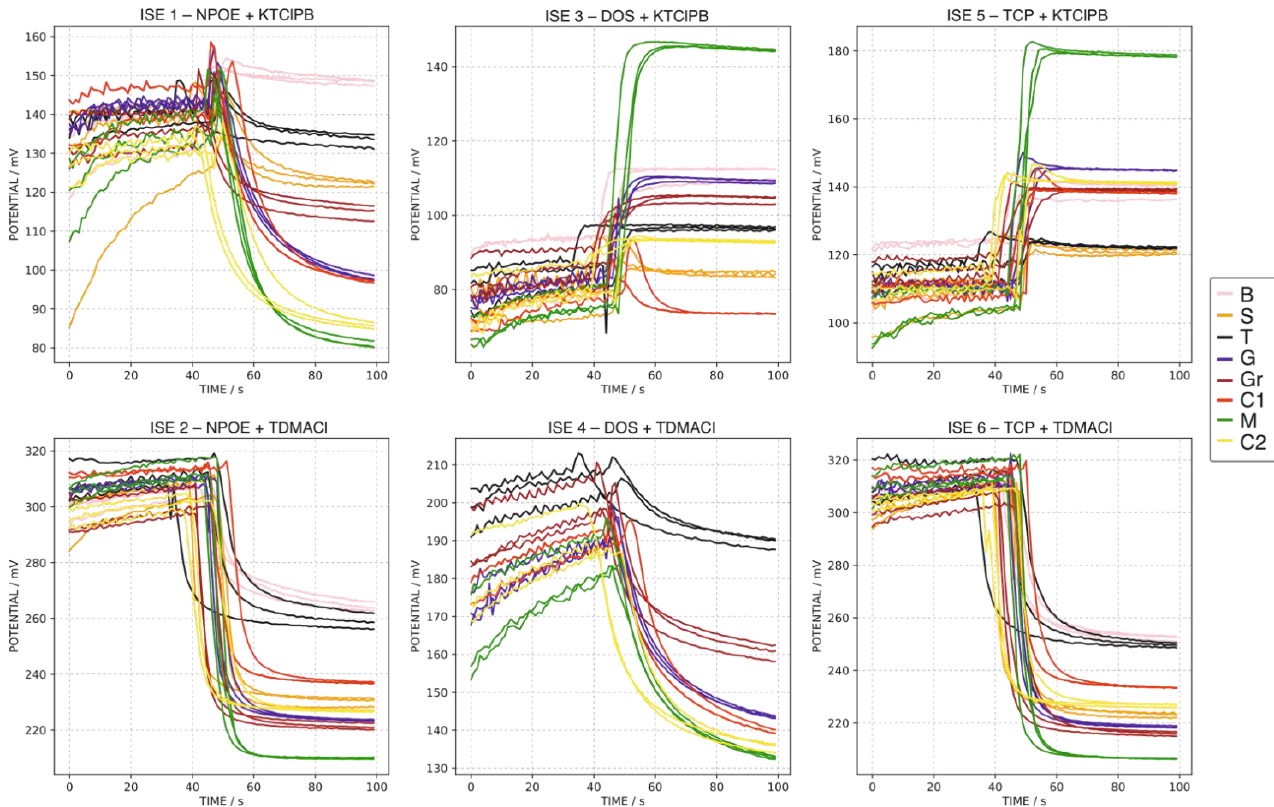
Figure 4. Triplicate dynamic potential response of ISEs 1 – 6 observed for all the water samples, ex- cept MT, applying the second measurement protocol (1.0 × 10 −6 M KCl background). MT, applying the second measurement protocol (1.0 × 10 − 6 M KCl